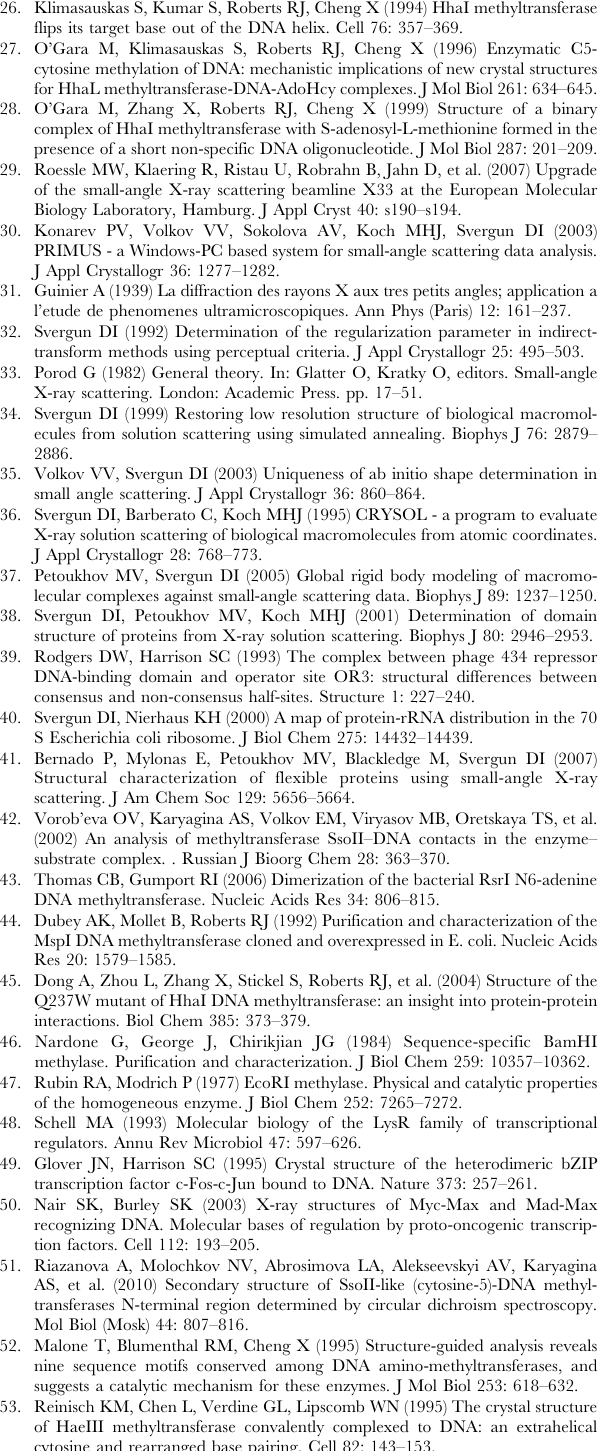
Figure S4 Kratky plots corresponding to the data in Figure 1. Experimental SAXS profiles were appropriately displaced along the logarithmic axis for better